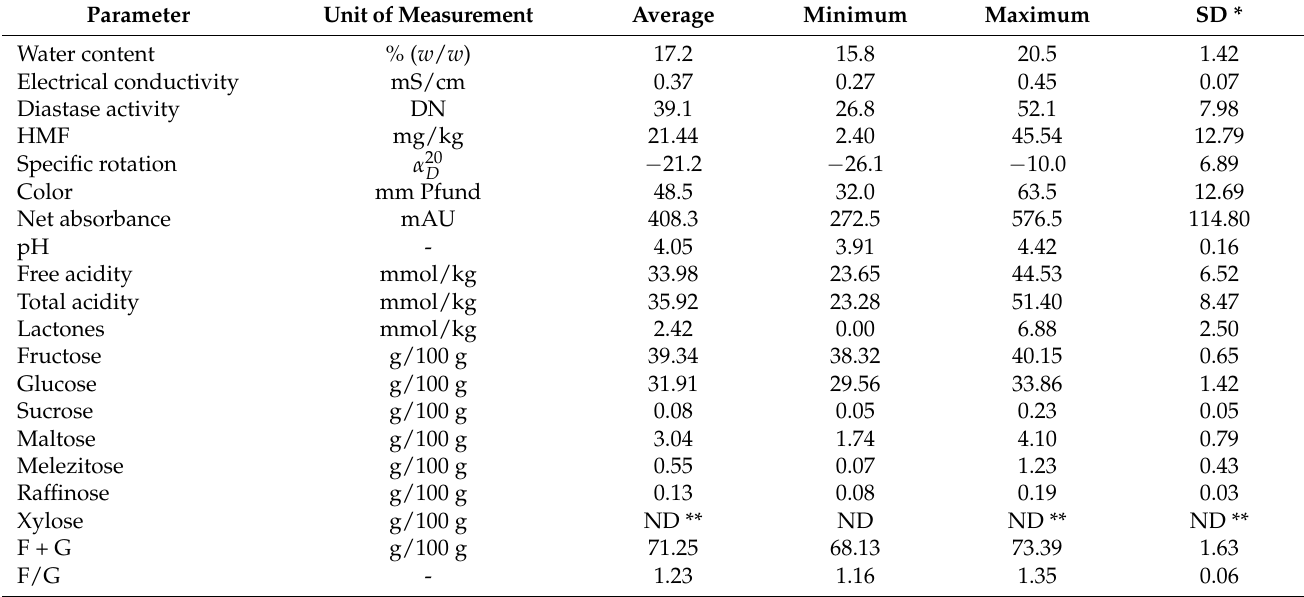
Table 1. Physicochemical parameters of Himalayan balsam honey.